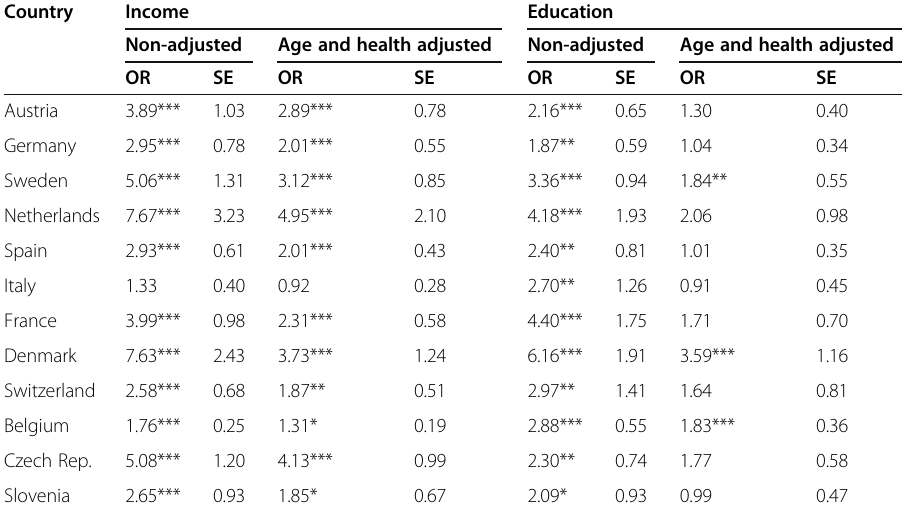
Table 2 Odds ratios of being in a nursing home by couple household income and education